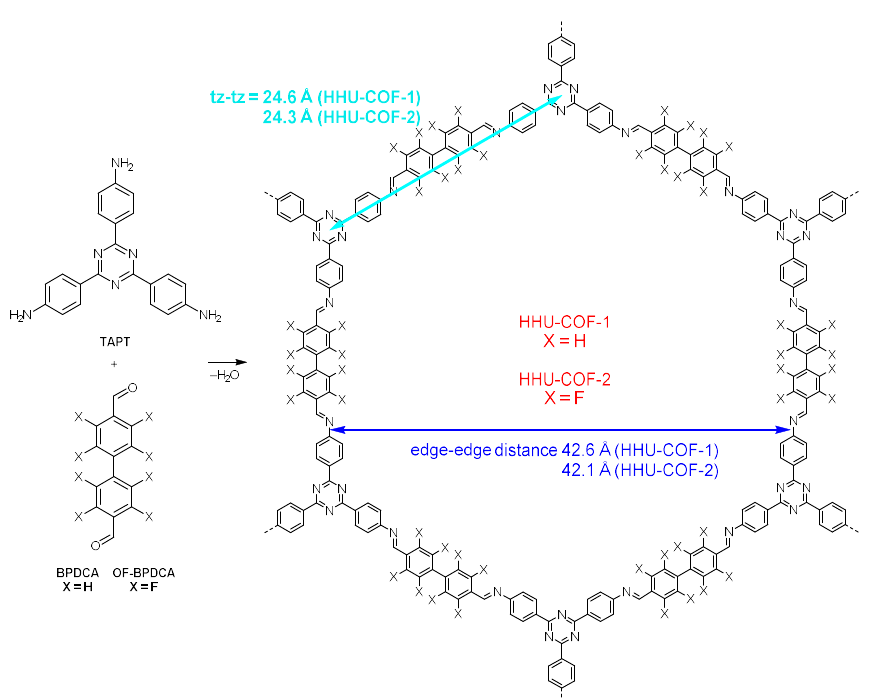
Scheme 1. Schematic formation of HHU-COF-1 and HHU-COF-2 from TAPT and BPDCA or OF-BPDCA, respectively, indicating the idealized hexagonal ring and network in the HHU-COF products (HHU = Heinrich-Heine University). The given triazine-centroid triazine-centroid (tz-tz) distance along the edges and the edge-edge distances were determined from the most intense (100) reflexes in the powder X-ray diffractograms, assuming a hexagonal unit cell for the honeycomb layer (cf. Figure S16). The given tz-tz distance along the edge is half the tz-tz distance across the ring.